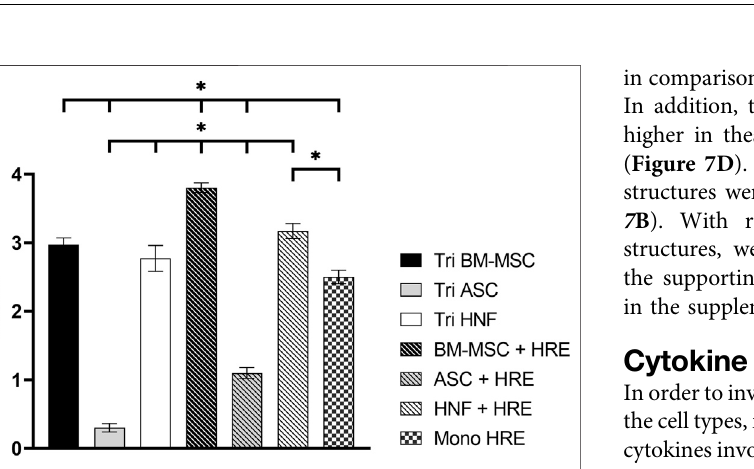
FIGURE 5 | Ciliation scoring of co-cultures with HRE, tri-cultures and HRE in monoculture. Scoring results revealed statistically signi fi cant differencesbetweenmostgroupsexcepttri-culturescontainingBM-MSCand co-culture or tri-culture with HNF. Additionally, the HRE monoculture wasfoundtobenon-signi fi cantlydifferentfromtheHNF-triculture. Results are expressed as mean ± SD following Gaussian error propagation. Statistically signi fi cant differences ( p < 0.05) are indicated by “ * ”